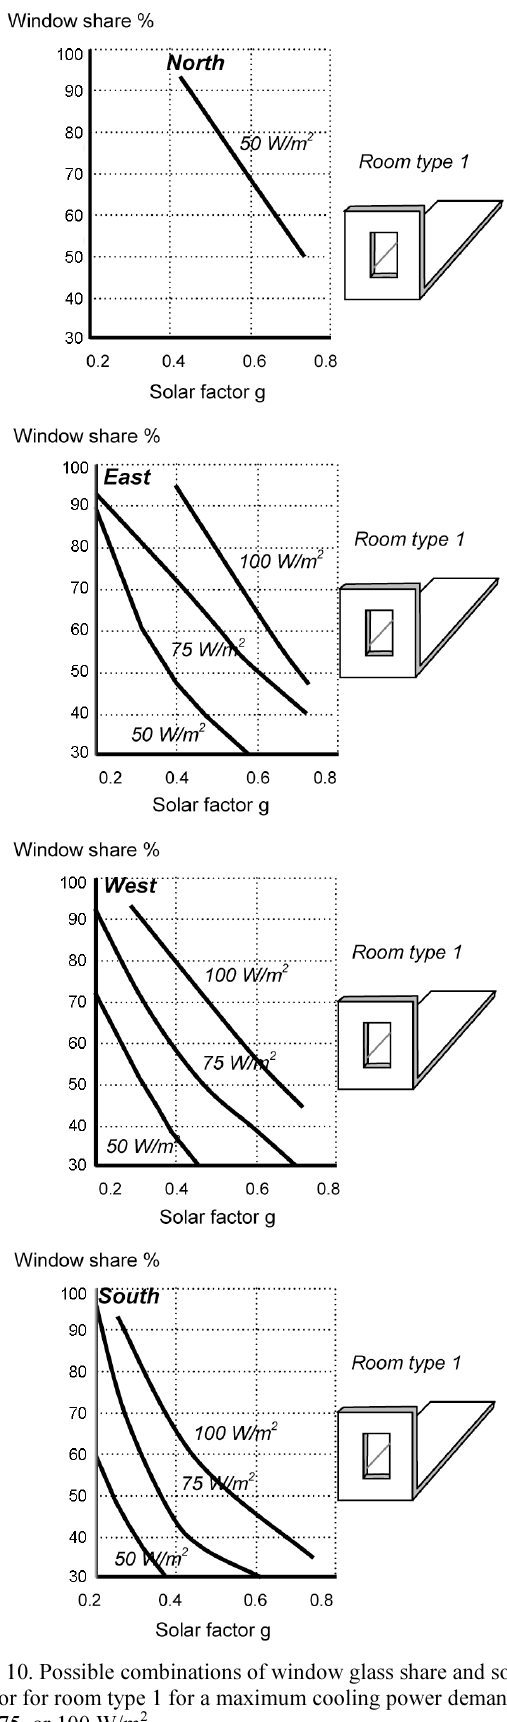
Fig. 10. Possible combinations of window glass share and solar factor for room type 1 for a maximum cooling power demand of 50, 75, or 100 W/m